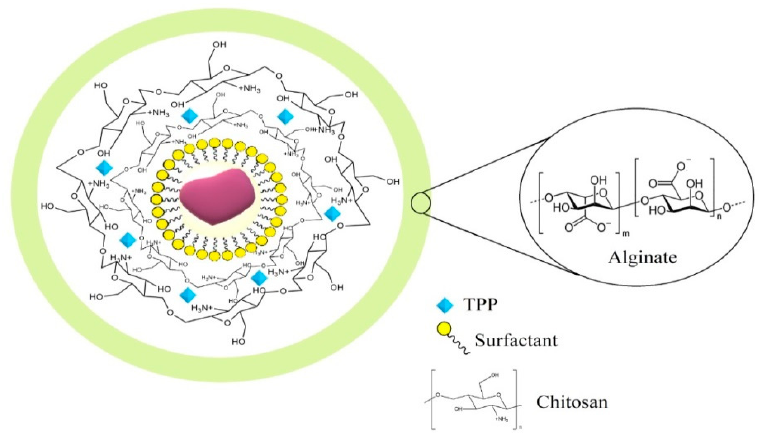
Figure 2. Hypothetical representation of the structure of cardanol-loaded CHI-TPP-ALG NPs.